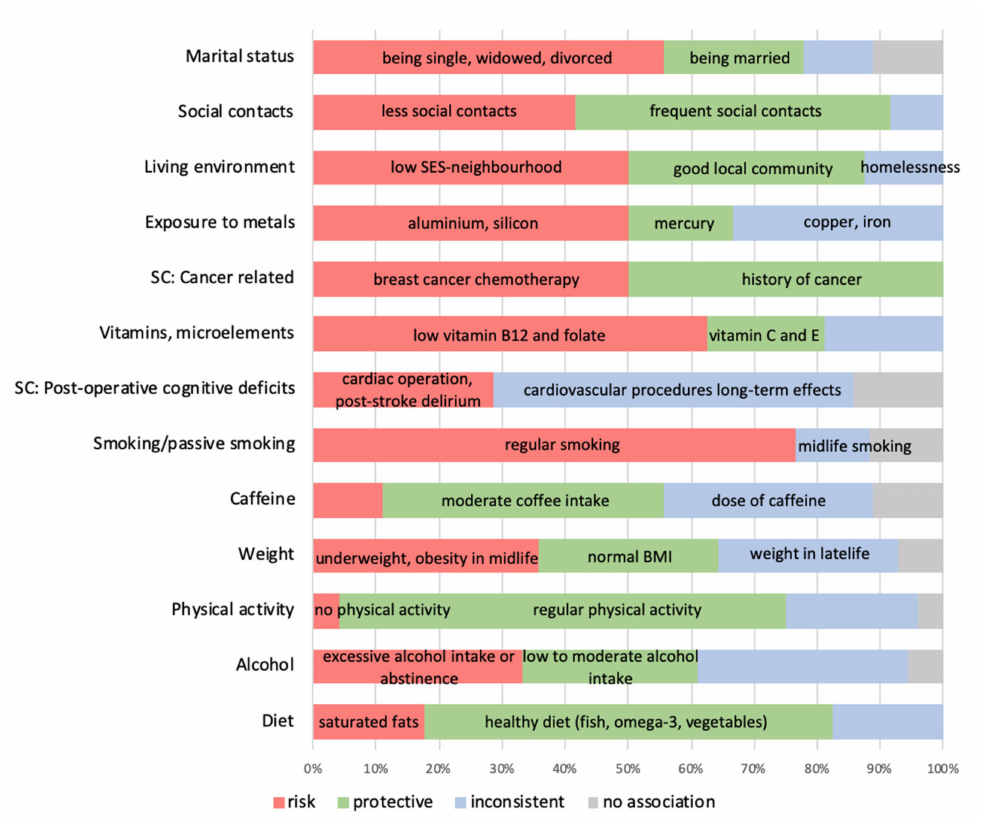
Figure 7. Factors with inconsistent or dual association with